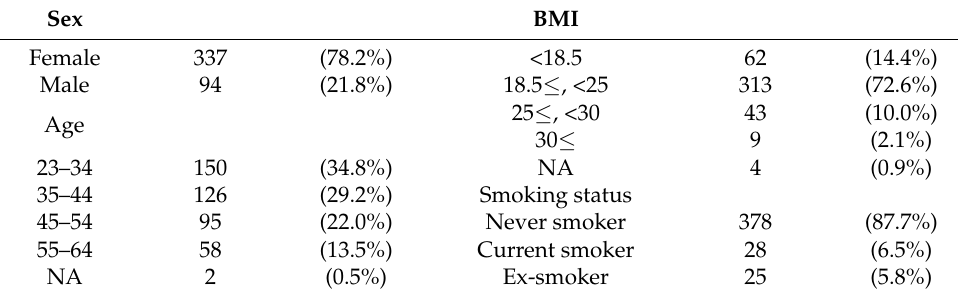
Table 1. The demographic characteristics of the